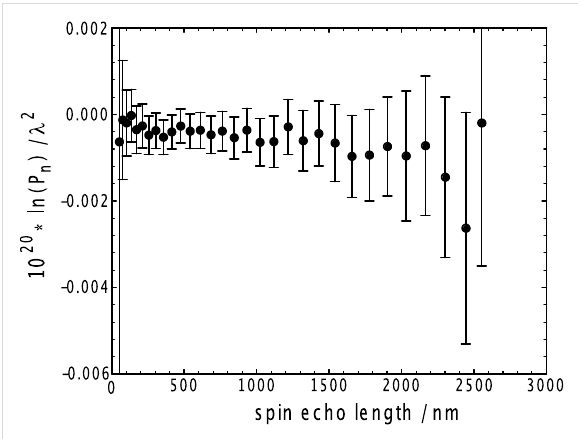
Figure 7: SESANS data for 50 mg ml − 1 G 6 in deuterated toluene, 25 °C.